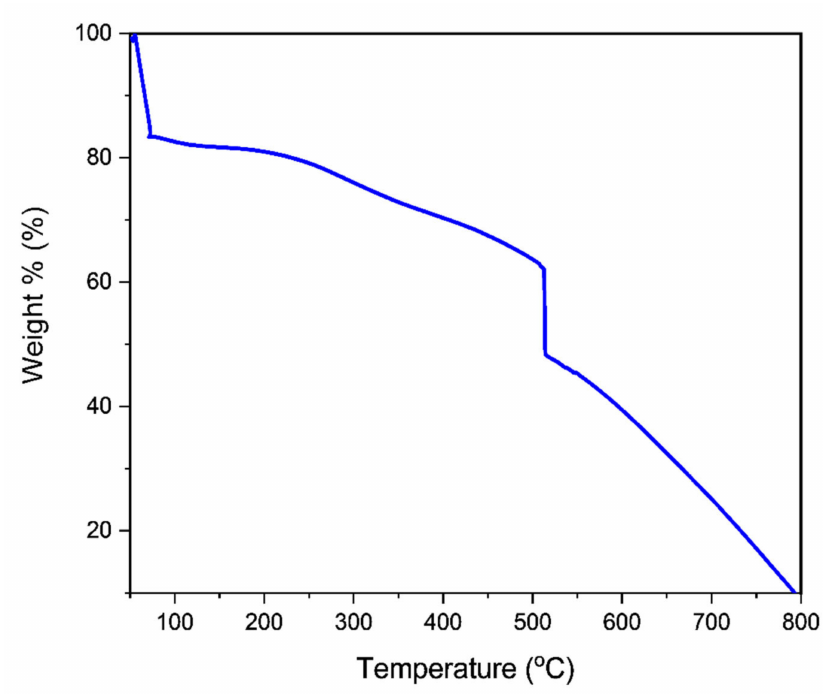
Figure 6. TGA graph representing the temperature-dependent thermal breakdown of PPy-PEI.